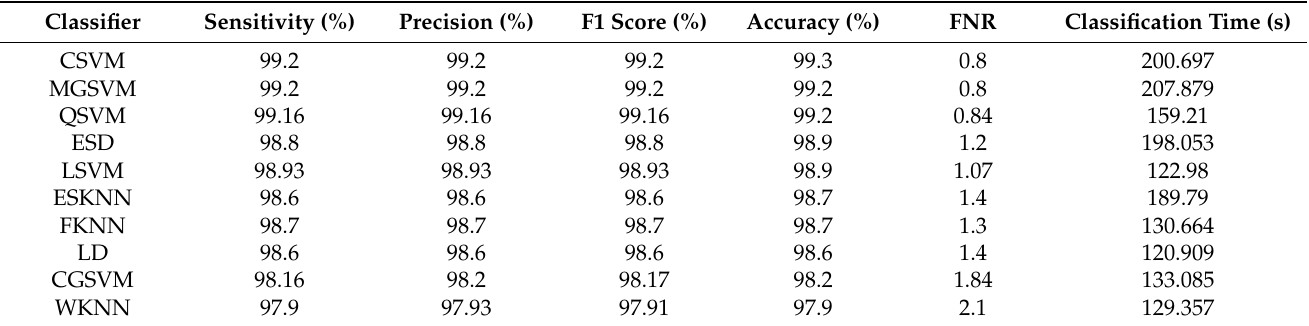
Table 2. Classification results of DarknNet53 using ultrasound images, where the training/testing ratio is 50:50.